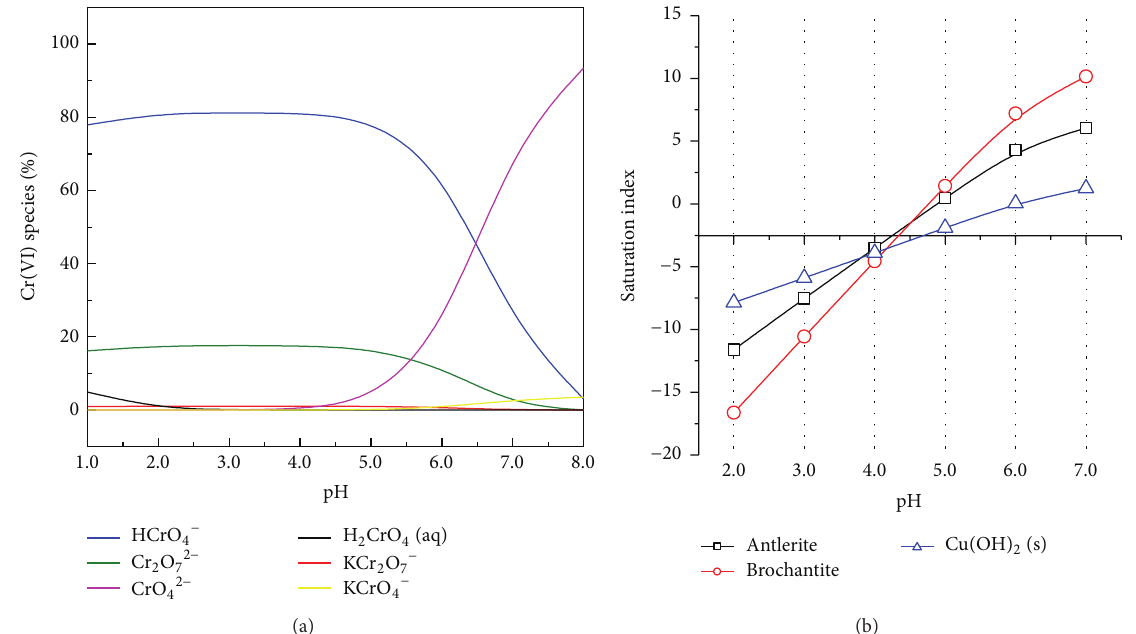
Figure 7: The speciation pH plot of Cr(VI) (a) in absence of Cu(II) and the saturation index with mineral precipitations in solution with